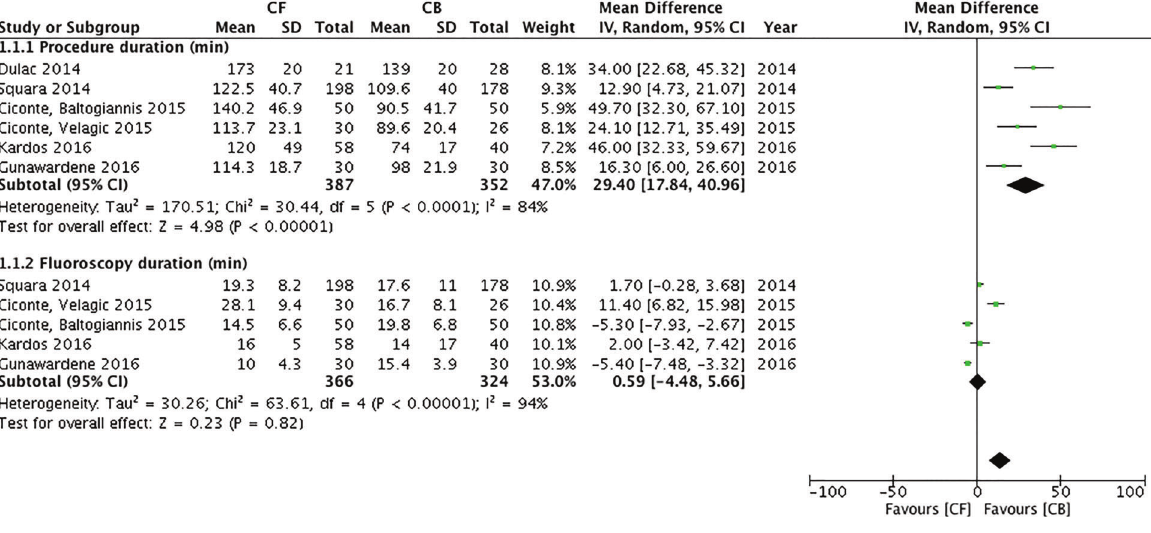
Figure 3. Forest plot showing unadjusted difference in the mean procedural duration of the contact force (CF) group compared with the cryoballoon (CB) group.